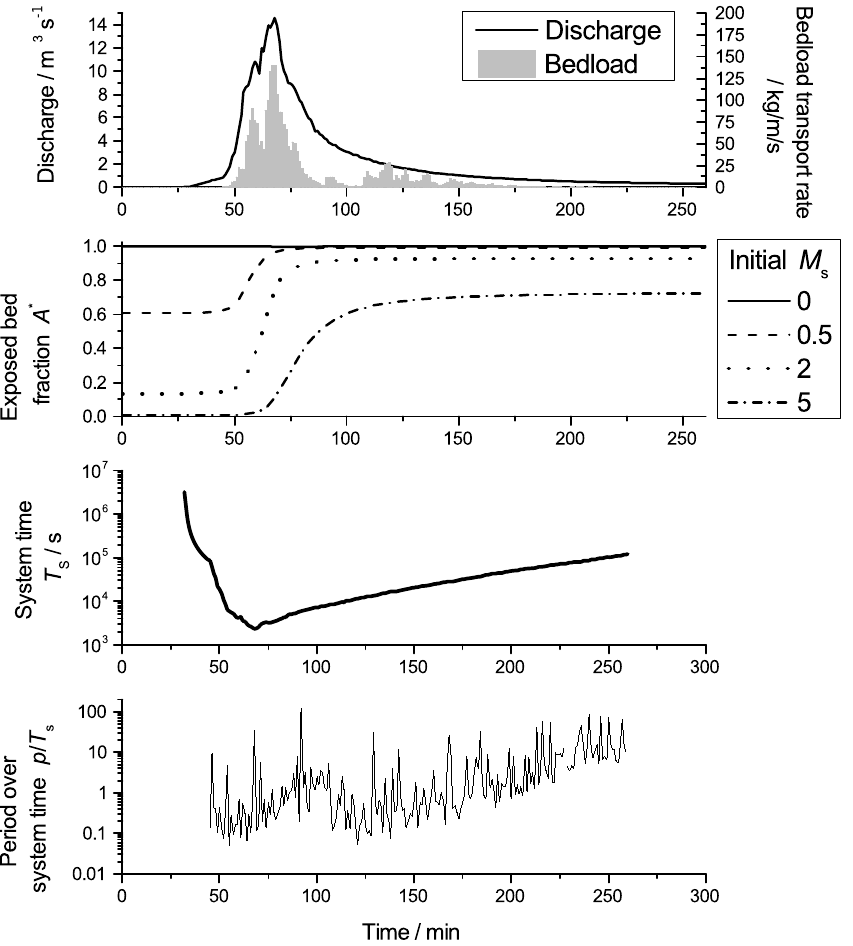
Figure 14. Calculated evolution of cover during the largest event observed at the Erlenbach on 20 June 2007 (Turowski et al., 2009). Bedload transport rates were measured with the Swiss Plate geophone sensors calibrated with direct bedload samples (Rickenmann et al., 2012). The final fraction of exposed bedrock is strongly dependent on its initial